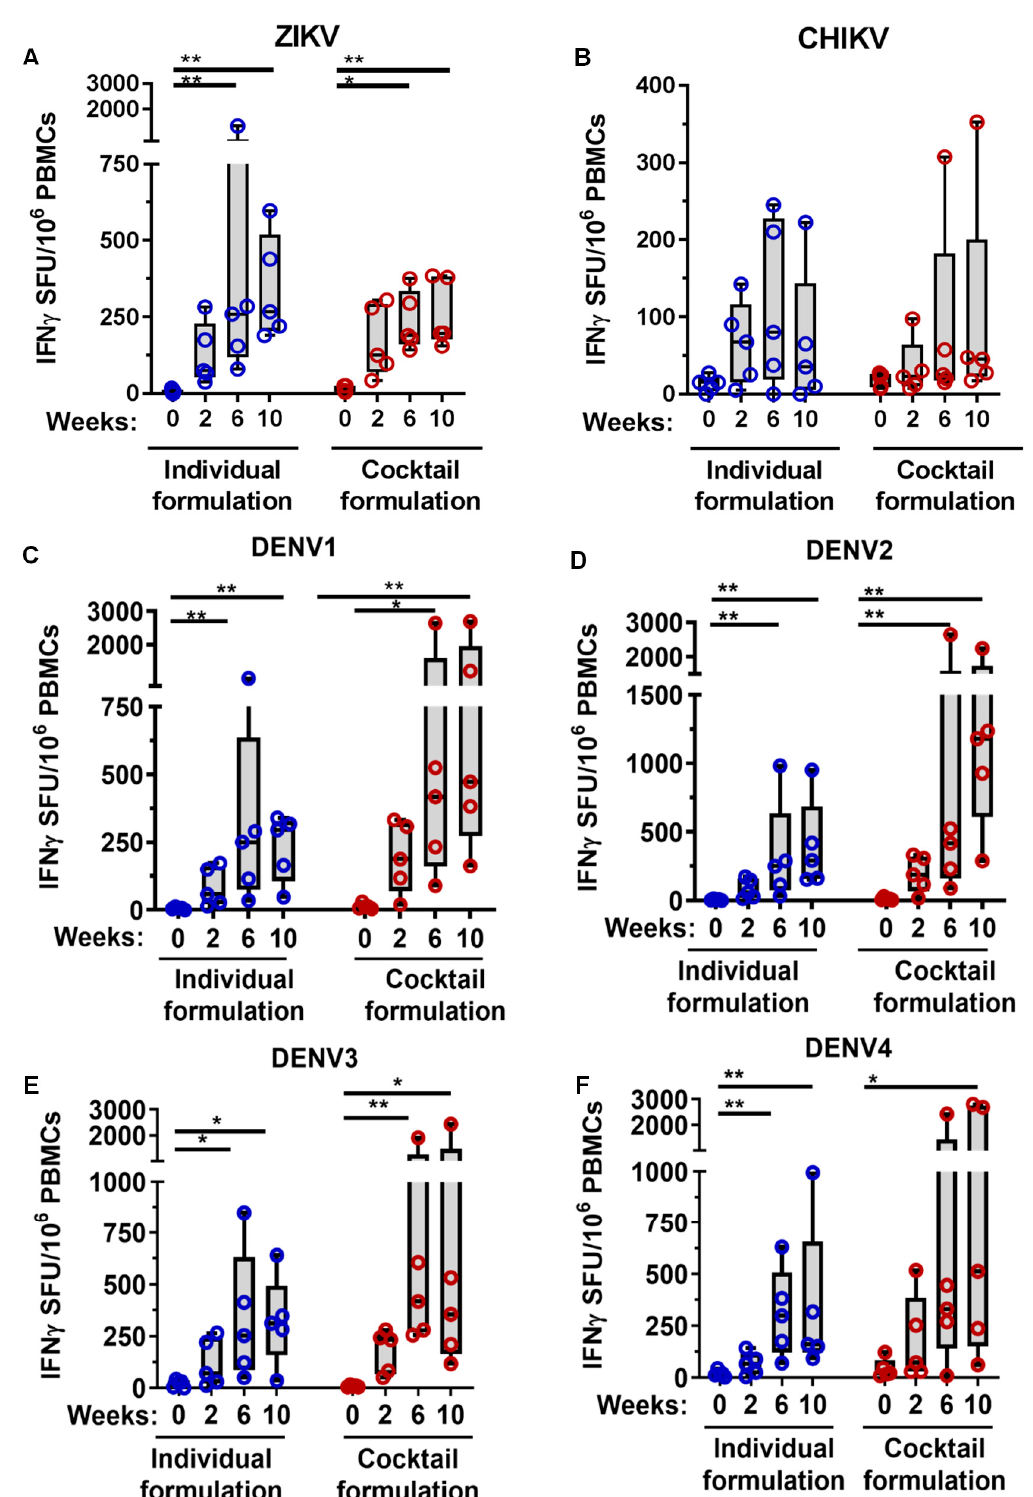
Figure 5. Cellular immune responses in NHPs after MMBV DNA vaccination via intradermal electroporation. Rhesus macaques were immunized as described in Figure 4. Specific T cell responses for individual NHPs at the indicated timepoints were measured by IFNy ELISpot following stimulation of PBMCs with ( A ) ZIKV, ( B ) CHIKV, ( C ) DENV1, ( D ) DENV2, ( E ) DENV3, and ( F ) DENV4 envelope peptide pools. The data represents SFUs per million PBMCs for each NHP. Asterisks indicate significant difference in SFUs compared to week 0 as described in the methods. There were no significant differences between individual and cocktail formulation treatment groups.